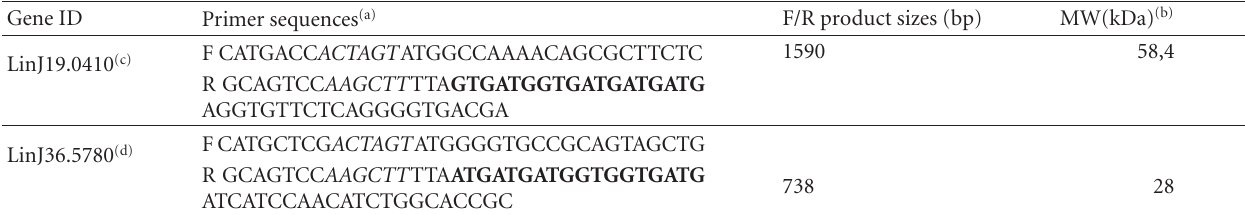
Table 3: Gene ID of L. infantum orthologous genes and primers used for cloning.